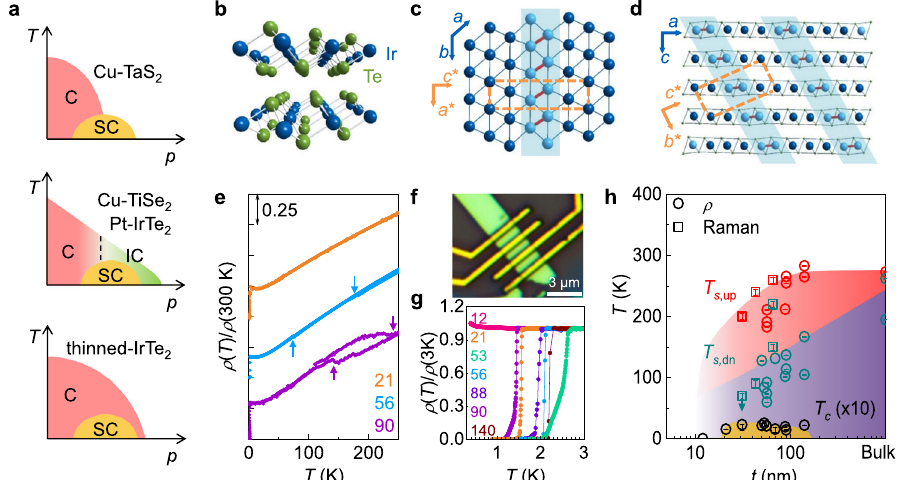
Fig. 1 Structure and phase diagram of IrTe 2 nano fl akes. a Schematic phase diagrams of TMDCs as a function of control parameter p , showing commensurate (C), incommensurate charge order (IC), and superconductivity (SC). Three different types of dome-shaped superconducting phase diagram, where the dome lies at the centre of a presumed quantum critical point (top), near the C-IC transition line (middle), or well inside the parent order (bottom). b Crystal structure of IrTe 2 . c , d Schematic illustrations of the stripe order in IrTe 2 below T s . The Ir-Ir dimerization (red) with a modulation vector ,0, 1 ) is depicted (blue shade) on the triangular Ir layer ( c ) and across the stacked layers ( d ). The crystallographic axes for the high- T ( a , b , and c ) and q = ( 1 5 5 the low- T ( a * , b * , and c * ) structures are shown, together with the unit cell of the stripe phase (orange box). e Temperature dependence of the normalised resistivity ρ ( T )/ ρ (300 K) for IrTe 2 crystals with thickness ( d ) of 21, 56, and 90 nm. For clarity, ρ ( T )/ ρ (300 K) curves are offset vertically. Transition temperatures T s ,up and T s ,dn are determined (arrows) in opposite temperature sweeps. f Optical microscope image of a 56-nm-thick IrTe 2 crystal. g ρ ( T )/ ρ (3 K) curves for IrTe 2 crystals with d = 12 – 140 nm. h Phase diagram of IrTe 2 nano fl akes as a function of thickness d , obtained by transport (circle) and Raman spectroscopy (square) measurements. The transition temperatures T s ,up (red) and T s ,dn (blue) during warming and cooling are plotted with the superconducting transition temperature T c (black), scaled by a factor of 10 for clarity. The error bars from the resistivity and Raman spectroscopy are de fi ned by the width of the corresponding resistive transitions and the temperature step of 5 K between the measurements,